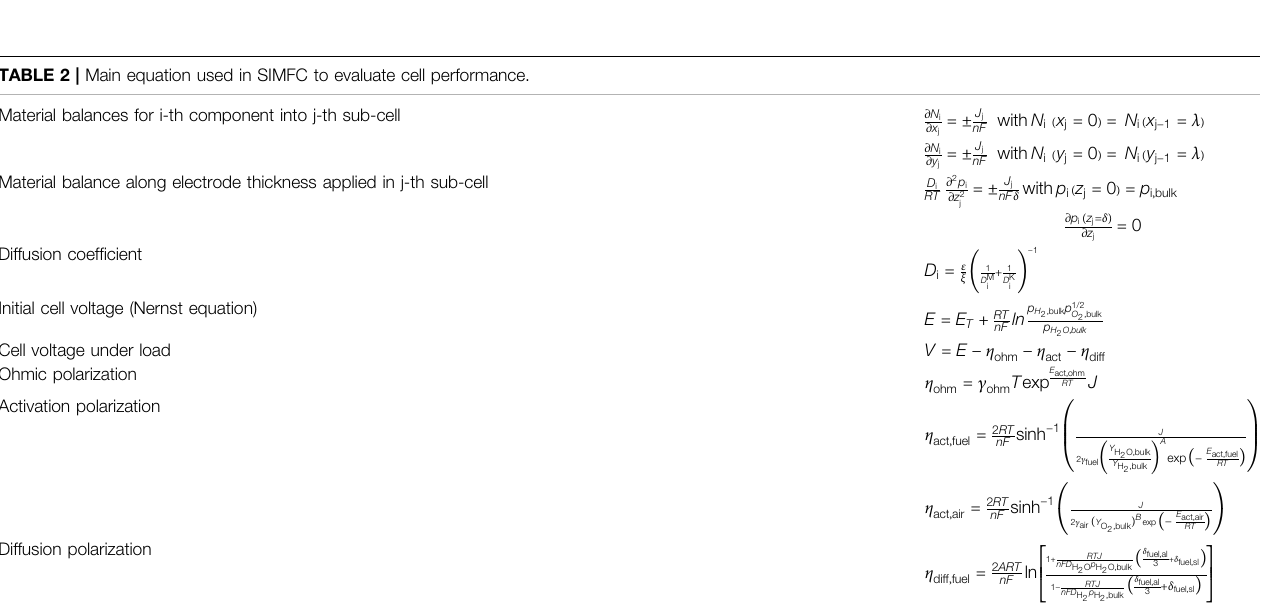
TABLE 2 | Main equation used in SIMFC to evaluate cell performance. Material balances for i-th component into j-th sub-cell